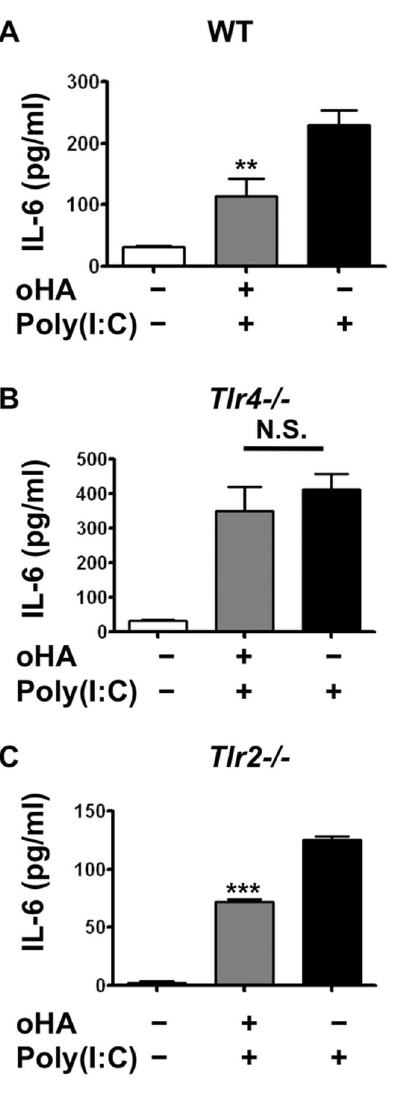
Figure 3. TLR4 is required for oligo-HA to suppress cytokine secretion and mRNA expression in peritoneal macrophages. WT (A), Tlr4 2 / 2 (B) and Tlr2 2 / 2 (C) peritoneal macrophages were treated with 10 m g/ml oligo-HA + 10 m g/ml poly(I:C), poly(I:C) alone or vehicle (PBS) for 24 h. IL-6 release in the cultured media was measured by ELISA. Data are means 6 S.E.M. and are representative of three independent experiments with n=3 per group. ***: p , 0.001, **: p , 0.01, N.S.: not